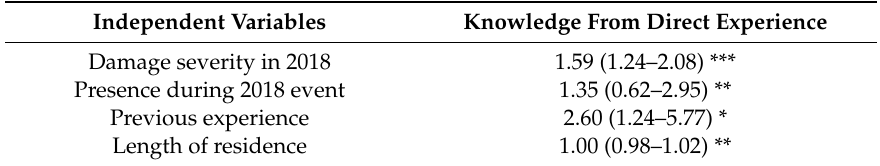
Table 4. Odds Ratios resulting from the multiple single regressions on the knowledge deriving from direct